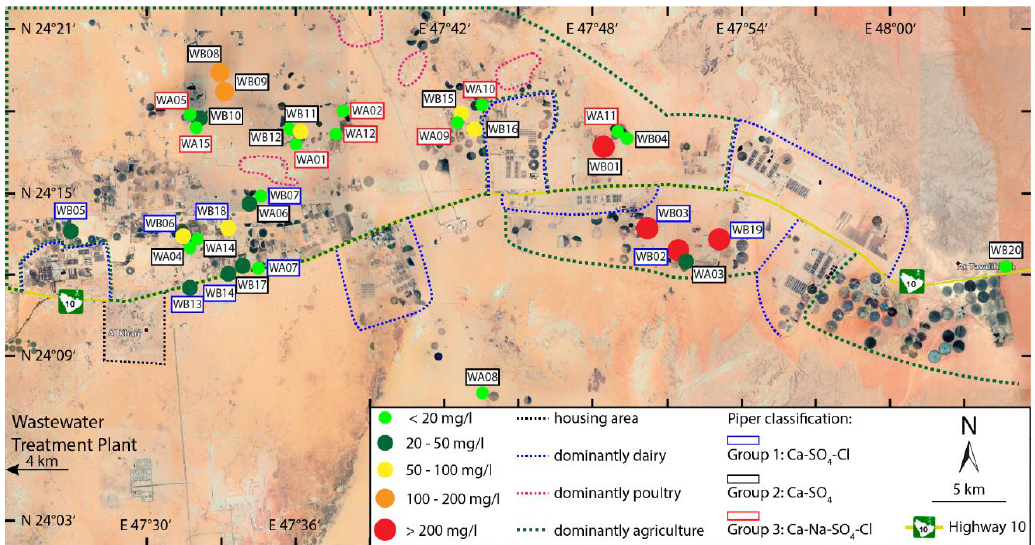
Figure 12. Google Earth map of measured nitrate concentrations of Wasia – Biyadh groundwater